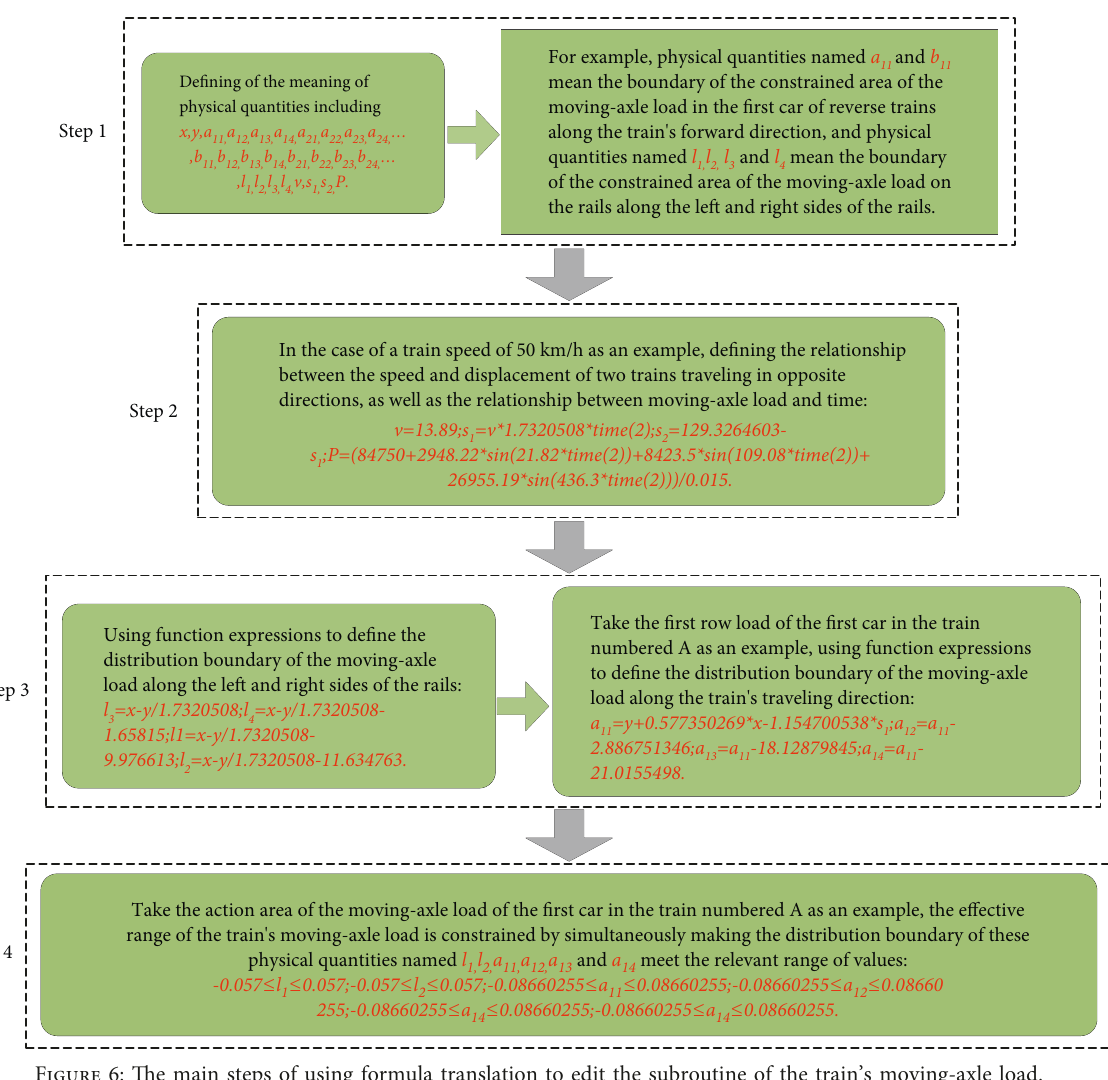
Figure 6: The main steps of using formula translation to edit the subroutine of the train’s moving-axle